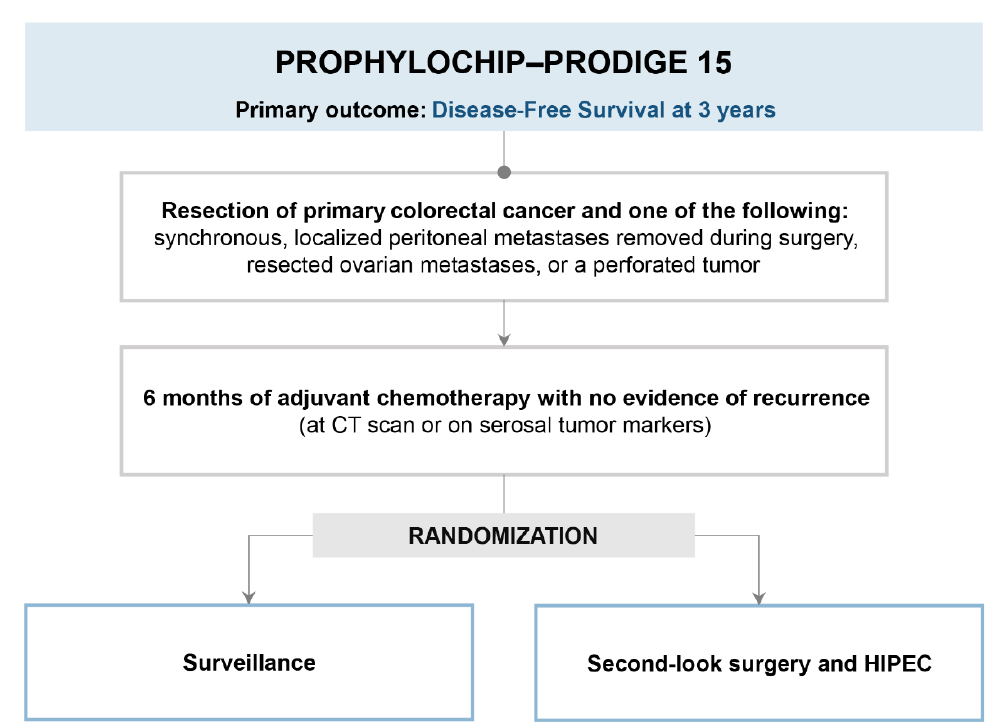
Figure 2. PROPHYLOCHIP-PRODIGE 15 trial design.